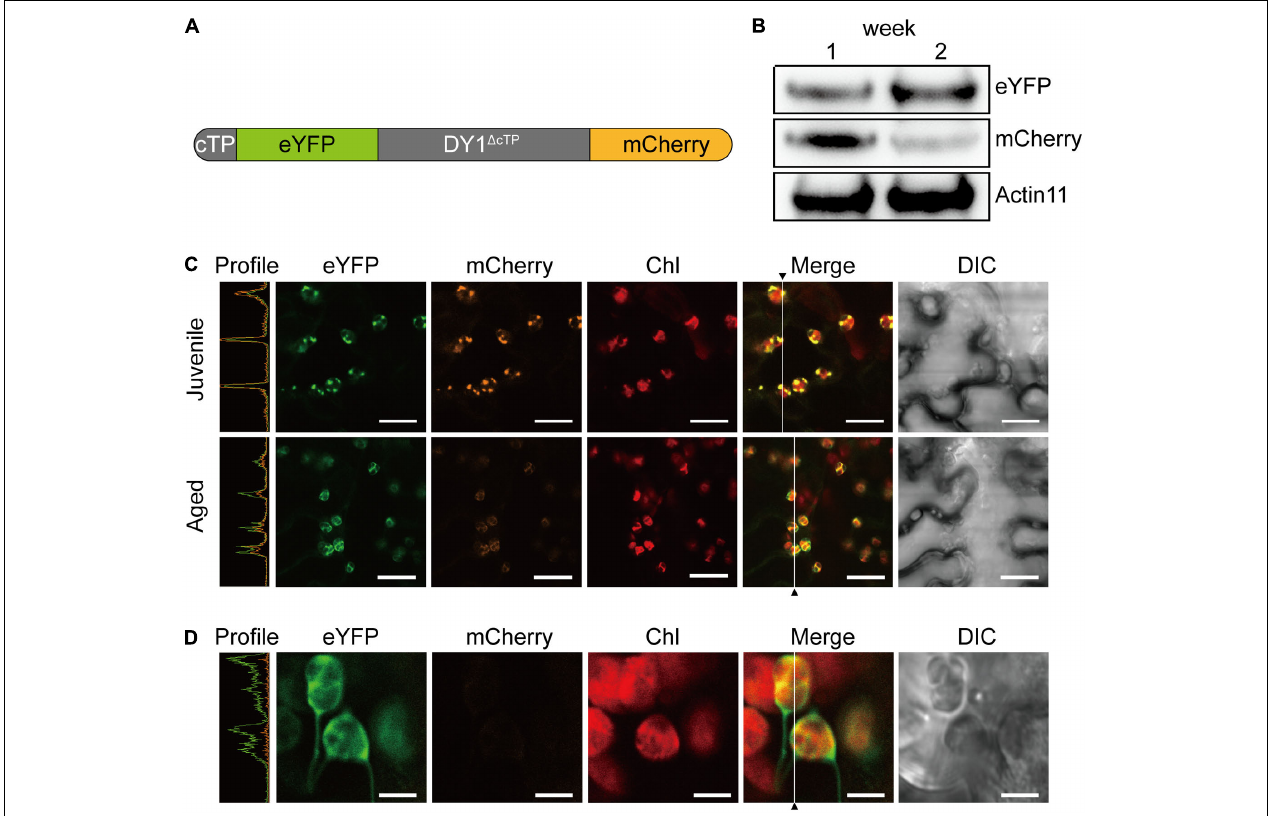
FIGURE 8 | Mature form of DY1 is further processed during the development of leaves. (A) A diagram showing the pre-protein structure of the DY1 protein labeled with dual fluorescent proteins. (B) Western blot analysis of the quantities of both ends of DY1 labeled with dual fluorescent proteins. Total proteins were extracted from 1- and 2-week-old transgenic Arabidopsis seedlings. (C) Transient expression of the eYFP-DY1-mCherry fusion protein in tobacco leaves demonstrating a possible cleavage of the C-terminus of DY1 during leaf development. Bars = 10 µ m. (D) Fluorescent observation of 2-week-old Arabidopsis seedlings showing the lack of mCherry signals. Bars = 5 µ m. In (C) and (D) , the Profile panels (green line, eYFP signal; orange line, mCherry signal) demonstrate the signal intensity profiles along the vertical lines indicated in the Merge